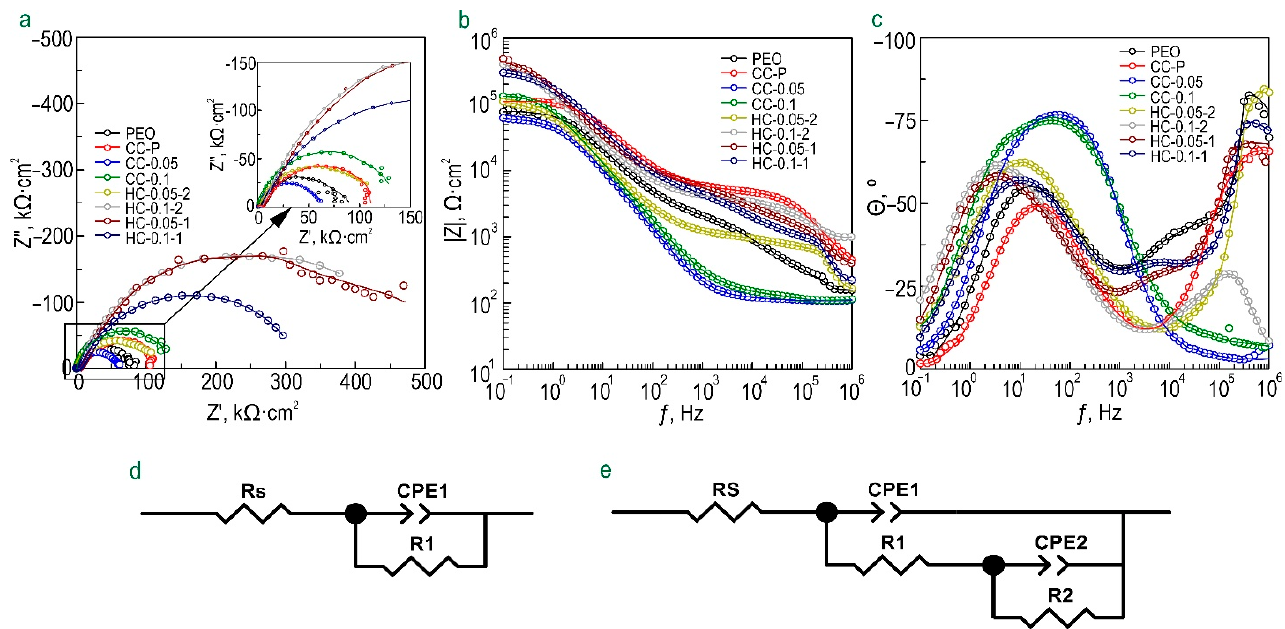
Figure 6. Impedance spectra presented in the form of Nyquist ( a ) and Bode ( b ), ( c ) diagrams after 1 h exposure of samples with benzotriazole-containing coatings to 0.9% NaCl solution. Equivalent electrical circuits (EECs) used to fit the experimental impedance spectra ( d , e ).